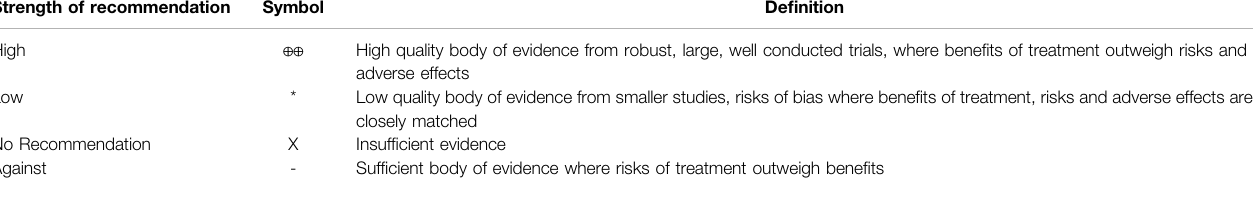
TABLE 1 | Strength of recommendation ratings, symbols used in subsequent statements and their corresponding de fi nitions. Strength of